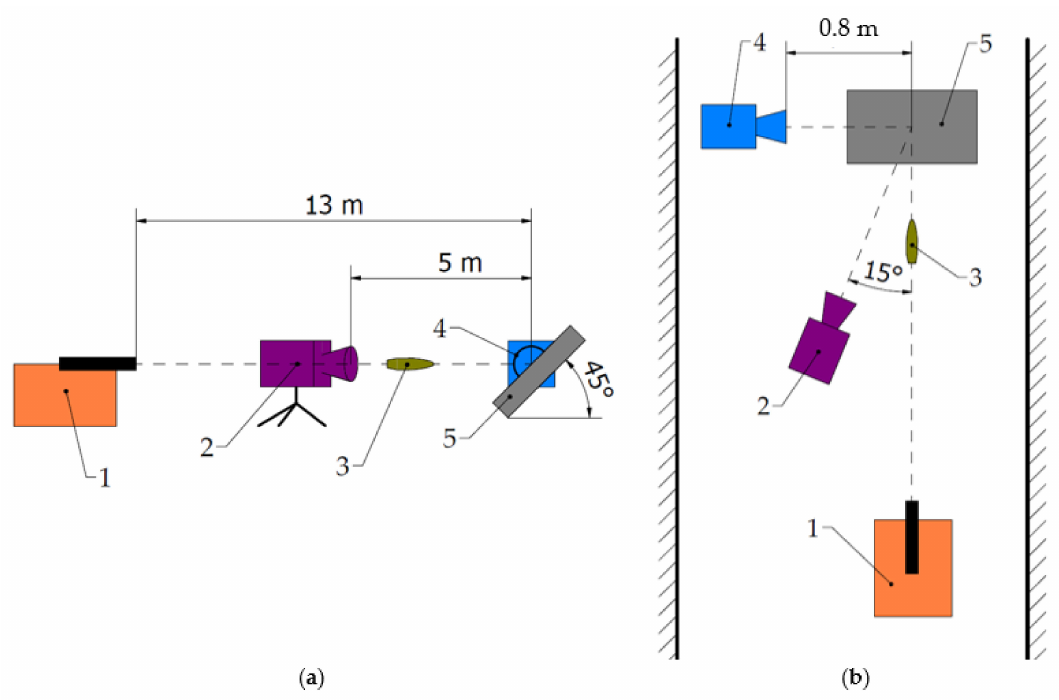
Figure 5. Schematic of the setup: ( a ) side view; ( b ) top view; 1—ballistic mount with barrel, 2—thermal camera, 3—projectile, 4—high-speed camera, 5—armour